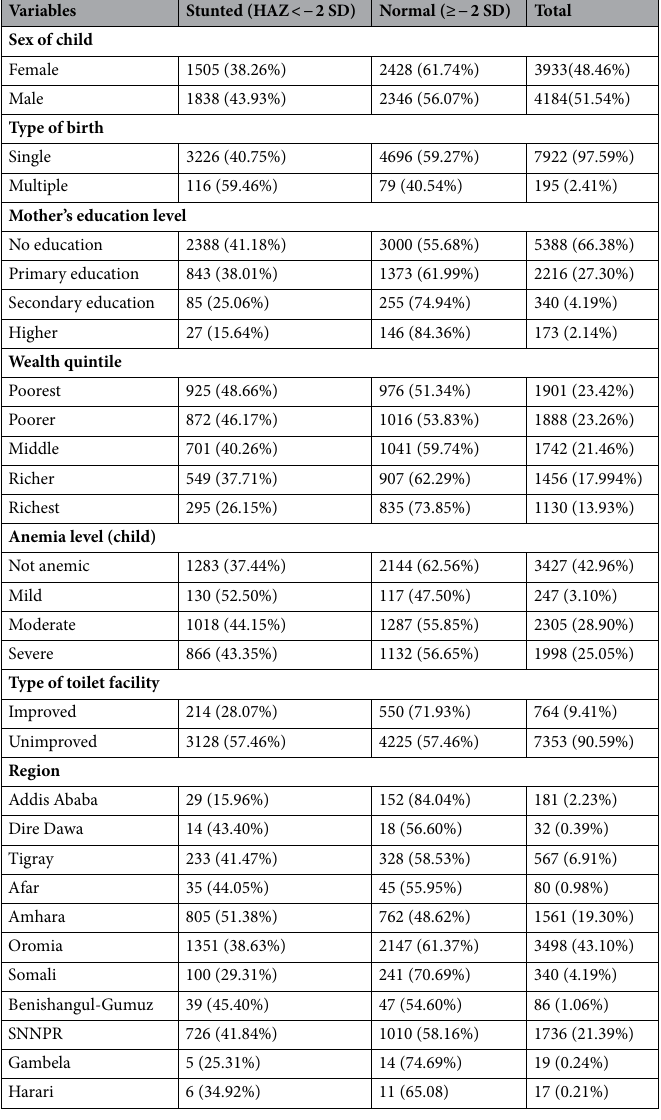
Table 2. Distribution of stunting by the selected characteristics among children aged 6–59 months in Ethiopia from January 18, 2016 to June 27, 2016 (n =